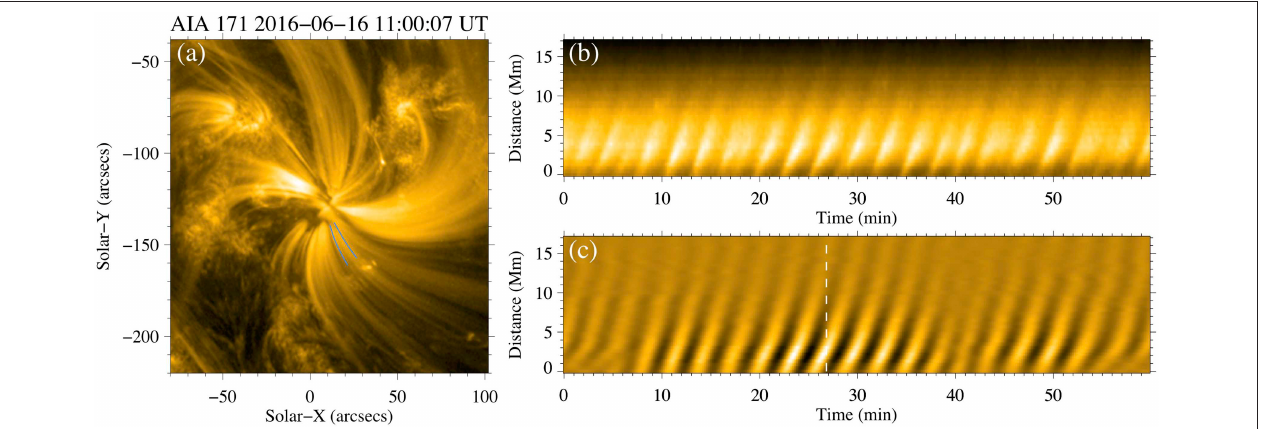
FIGURE 1 | (a) A snapshot of the fan-like loop structures from NOAA AR 12553 captured in the SDO/AIA 171Å channel. The blue solid lines mark the boundaries of a chosen loop segment. (b) Time-distance map depicting the evolution of the loop segment shown in (a) . The alternating slanted bands of brightness apparent in this map indicate the presence of propagating compressive oscillations due to slow magnetoacoustic waves. (c) Same as (b) , but processed to enhance the visibility of the brightness ridges by filtering the time series at each spatial position to allow only a narrow band of frequencies around the dominant oscillation period. The white dashed line marks the temporal location chosen to study the spatial damping characteristics shown in Figure 2